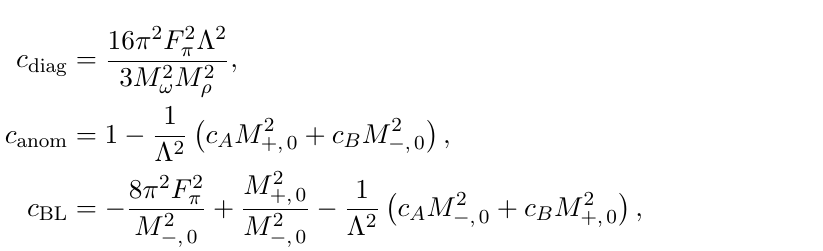
in (4.14), (4.15), and (4.17), the model parameters should be replaced